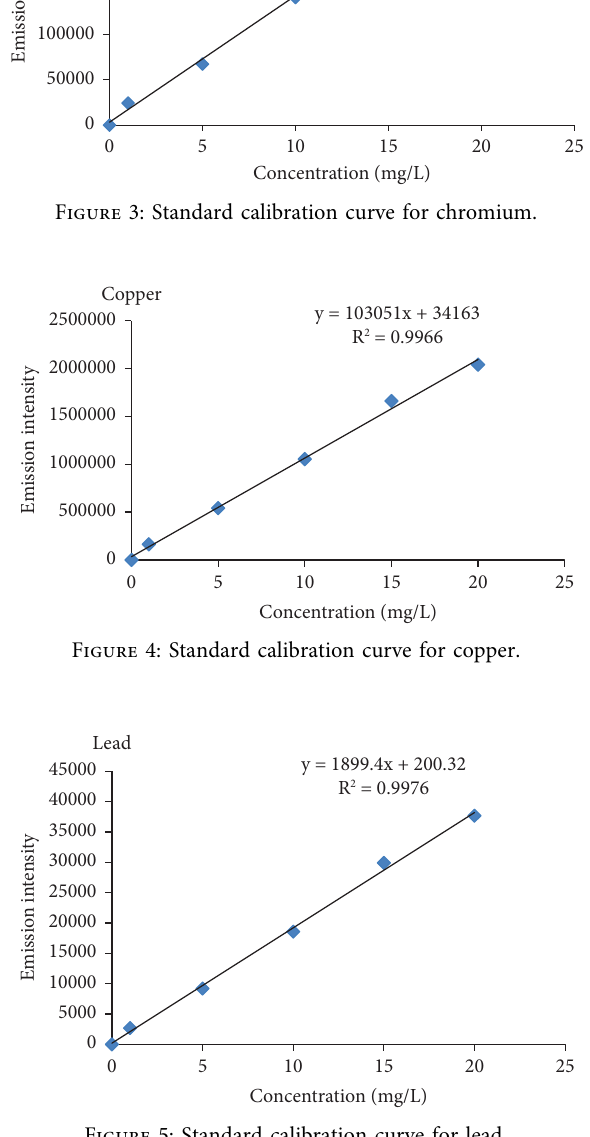
Figure 5: Standard calibration curve for